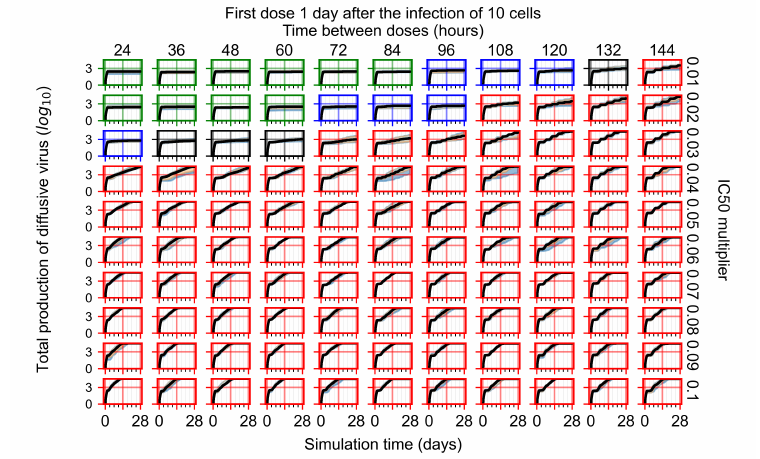
Figure A53. Total diffusive virus produced (AUC), Y axis in log scale, and exponent values as tick marks.